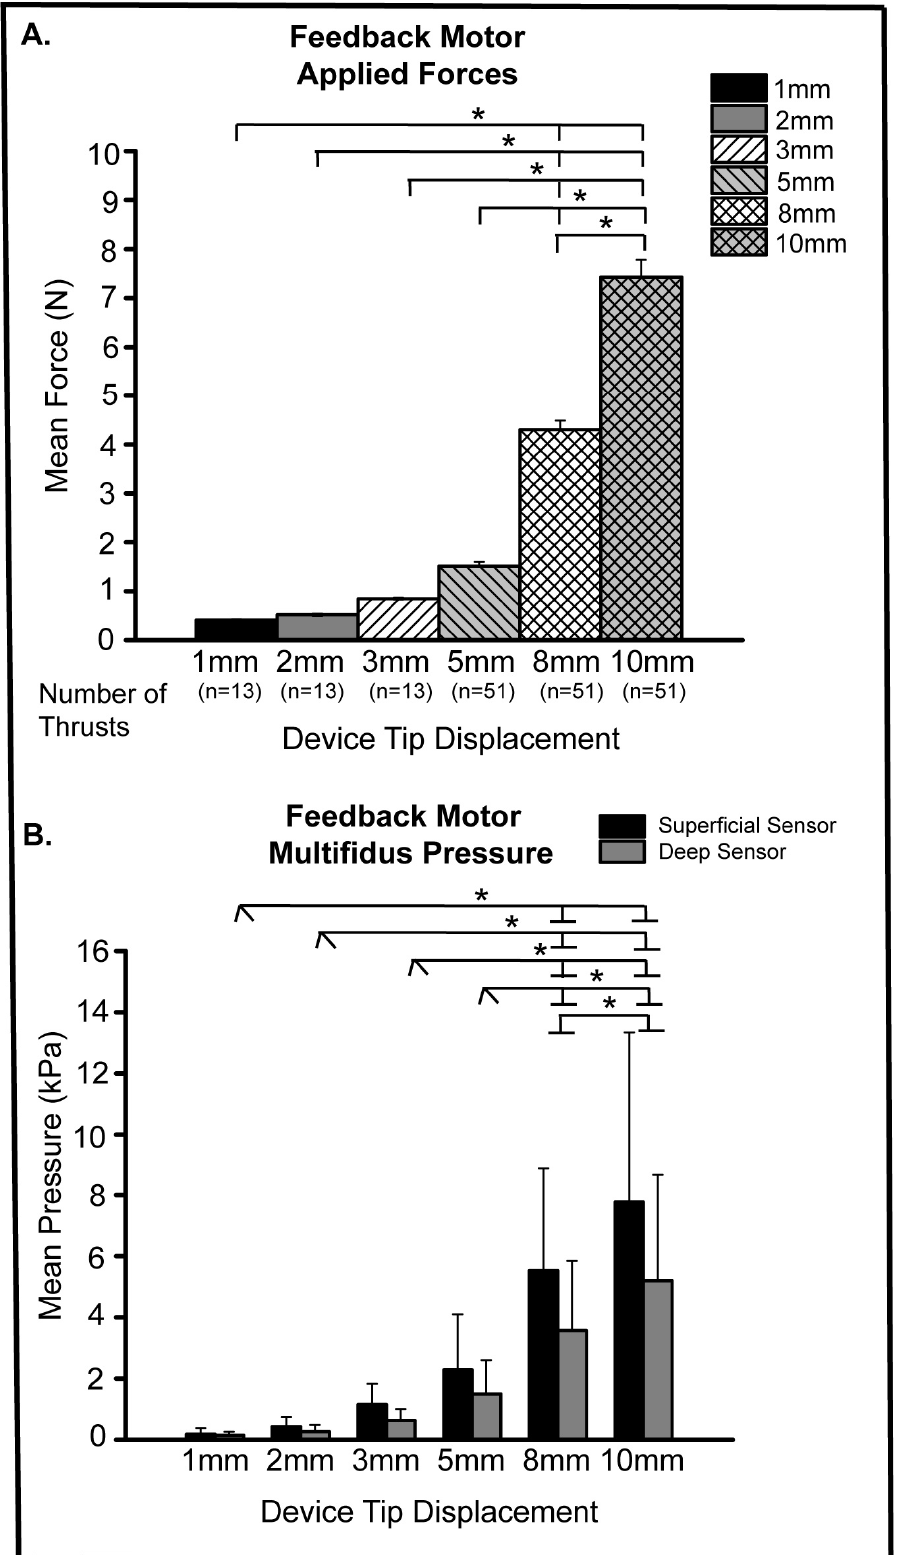
Figure 3. Feedback Motor Applied Force and Intramuscular Pressure. ( A ) Mean feedback motor applied forces for L7 spinal tissue displacements of 1, 2, 3, 5, 8, 10 mm (* p < 0.0001); ( B ) mean superficial and deep intramuscular pressures for L7 spinal tissue displacements of 1, 2, 3, 5, 8, 10 mm (* p ≤